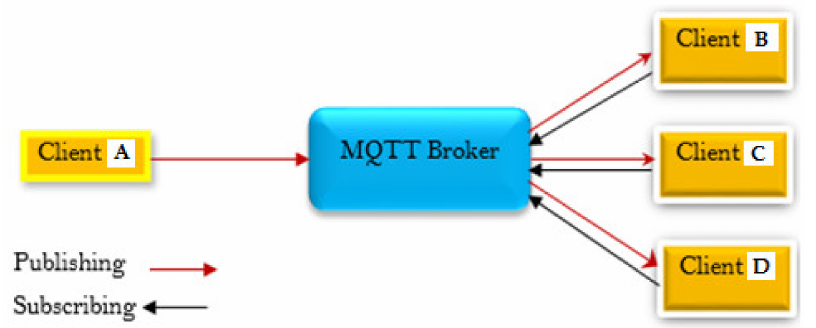
Figure 1. MQTT publish-subscribe